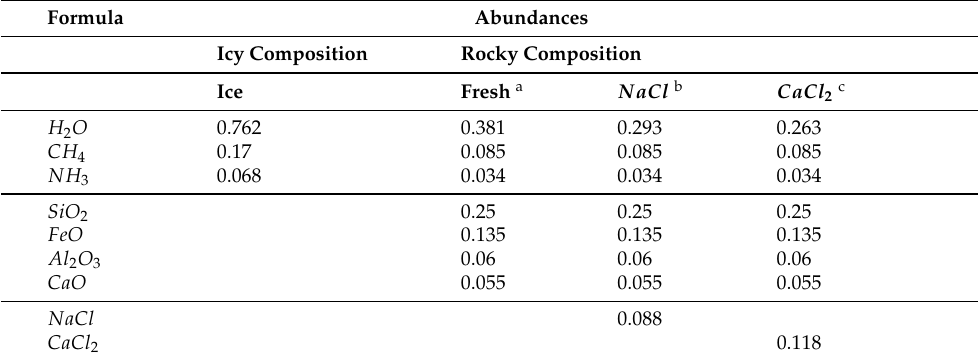
Table 1. Surface compositions.